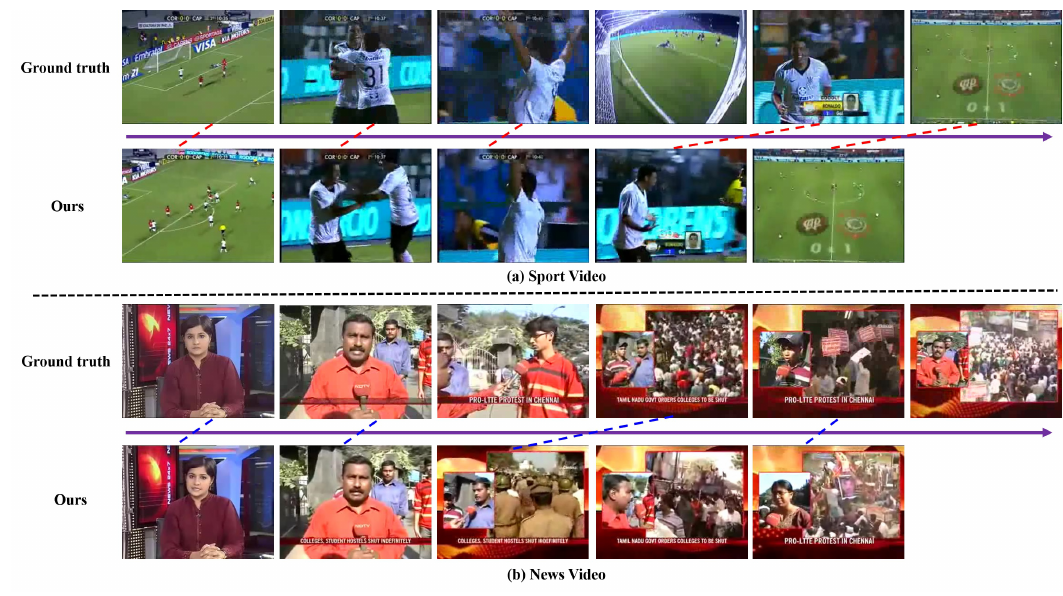
Figure 6. Examples of key frames detection of VSUMM dataset, along with the ground-truth key frames